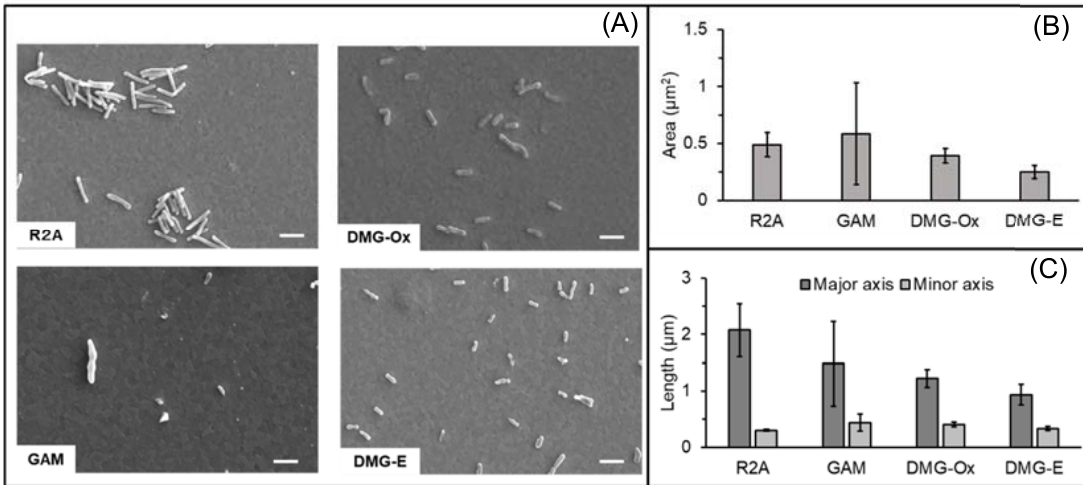
Figure 4. ( A ) Cells observed using scanning electron microscopy (SEM). Scale bar = 1.0 µ m. ( B ) Com ‐ parison of the observed area and ( C ) major axis and minor axis of cells after aerobic culture in R2A (R2A, n = 12), anaerobic culture in GAM (GAM, n = 15), aerobic culture in DMG (DMG; DMG ‐ Ox, n = 10), and electrochemical culture in DMG (DMG ‐ E, n = 18). Error bars represent standard deviation.